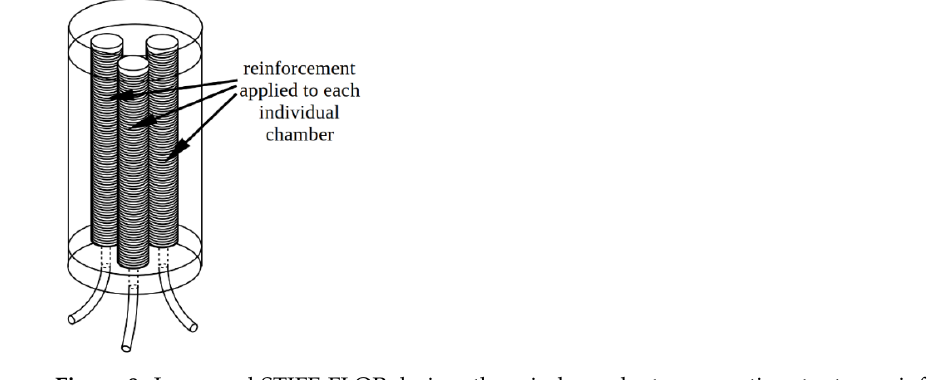
Figure 8. Improved STIFF-FLOP design; three independent pneumatic actuators reinforced with fibres arranged around the central axis, embedded into the soft body of the device [28].